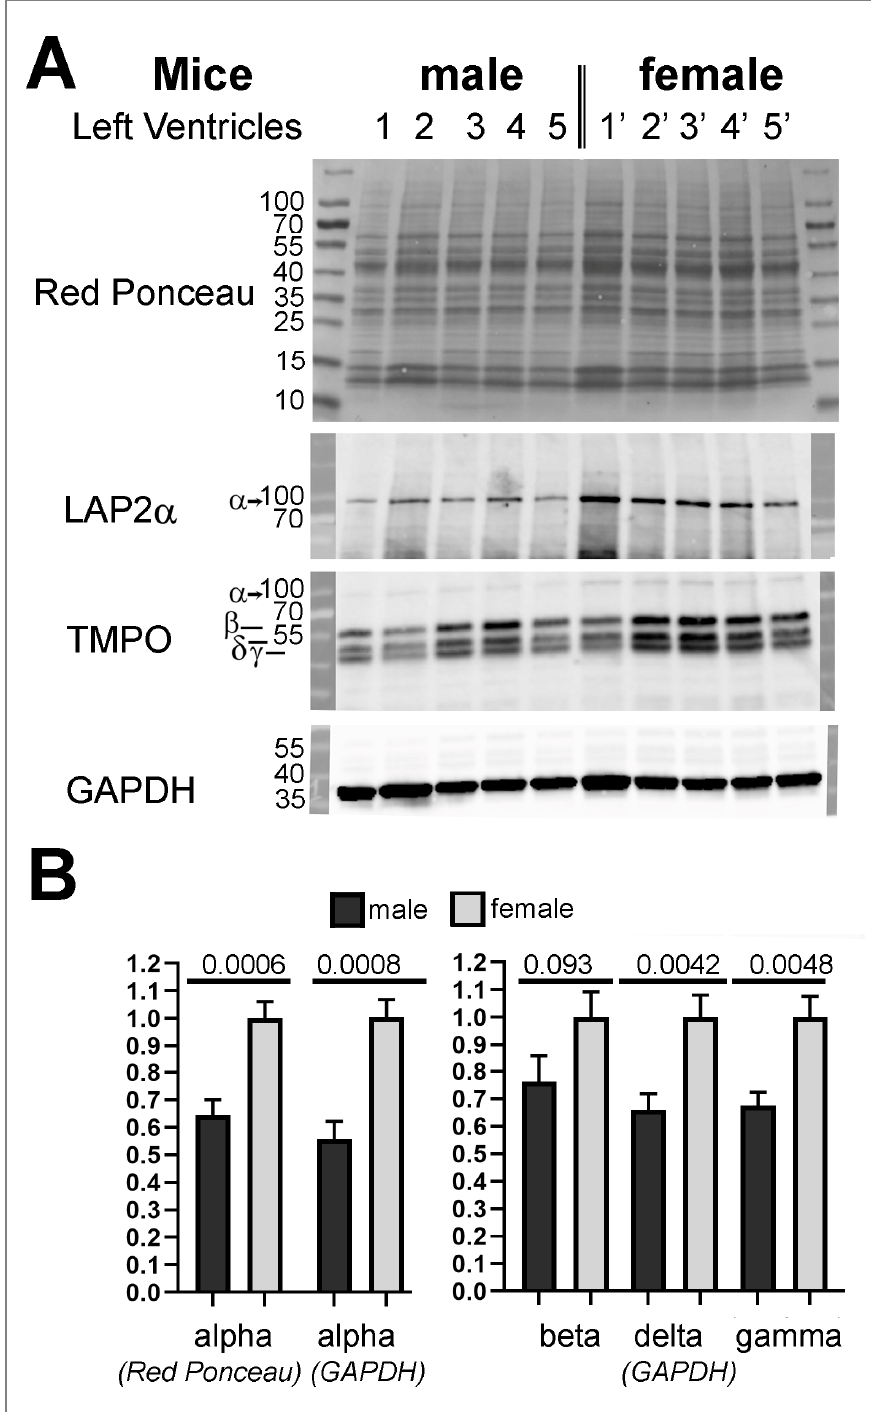
Figure 2. Relative expression level of LAP2 α and LAP2 β , δ , γ proteins in the hearts of male vs. female mice aged of 9 weeks. ( A ), Western blots are shown on whole extracts of LV from 5 male mice (1–5) and 5 female mice (1 (cid:48) –5 (cid:48) ) stained with red ponceau and incubated first with anti-LAP2 α antibodies and subsequently with TMPO antibodies (that recognize all LAP2 proteins). Red Ponceau staining or GAPDH were used to normalize ECL signals (Additional results related to 5 other male mice (6–10) and 5 other female mice (6 (cid:48) –10 (cid:48) ) are presented in Supplemental Figure S1). ( B ) The graph shows ECL signal quantification related to A) and Figure S1 (mean ± s.e.m; n = 10). For statistical analyses, precise p -values are